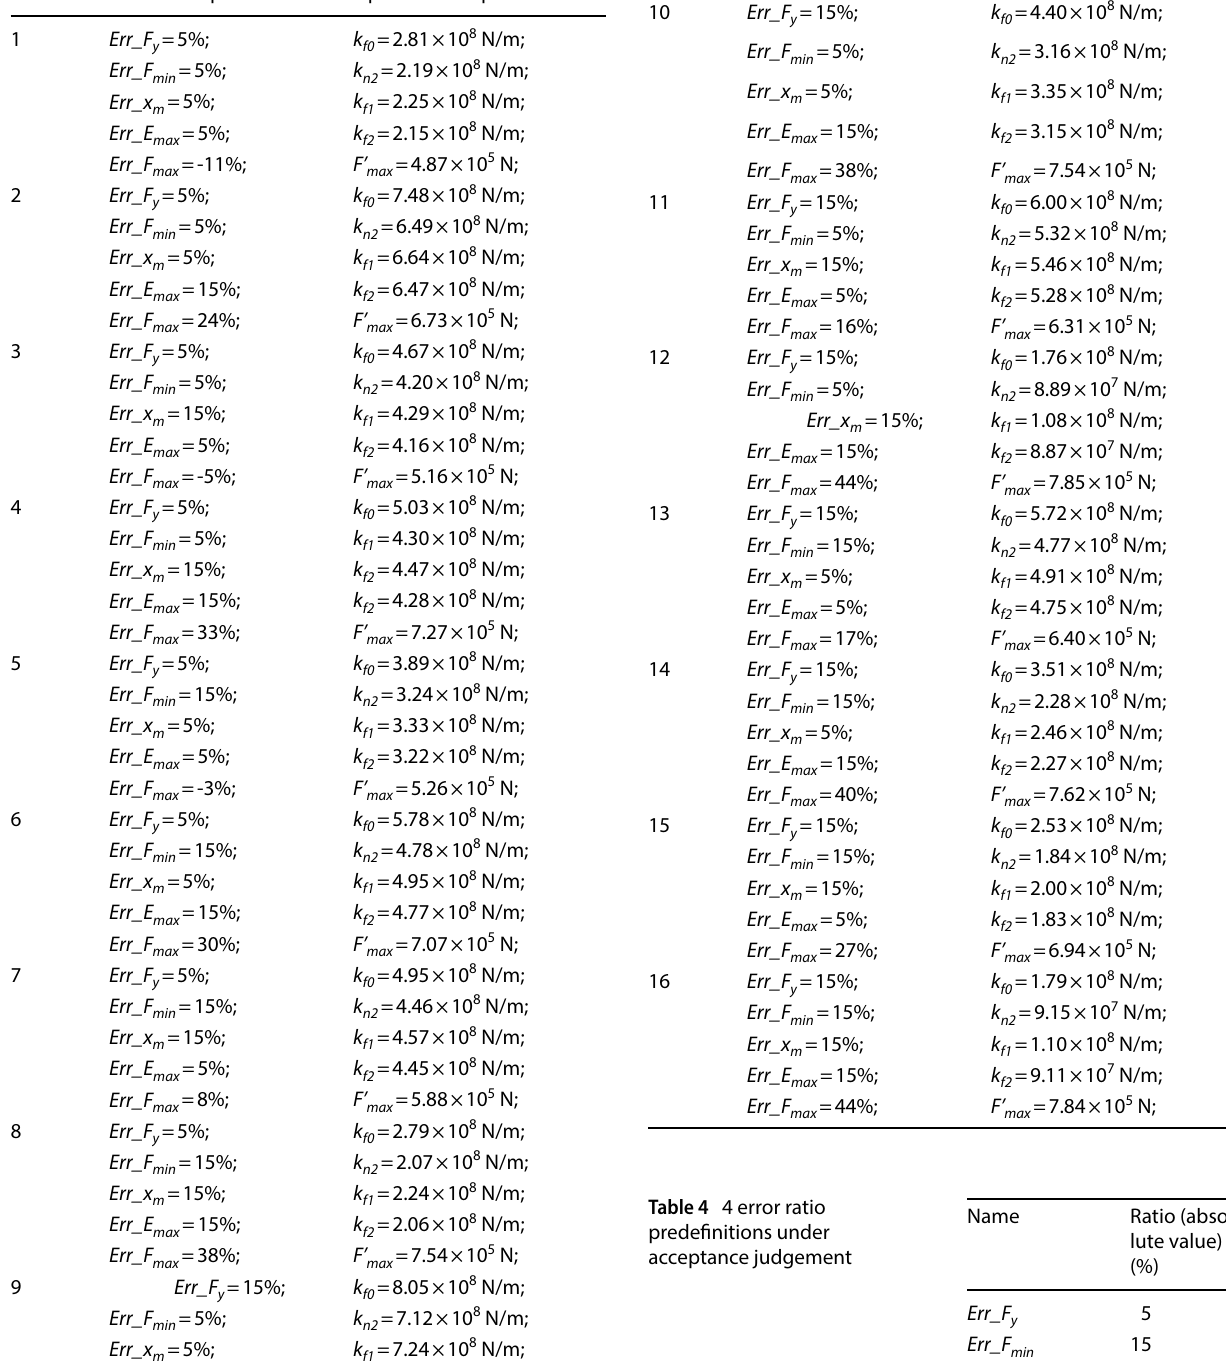
Table 3 Optimization outputs upon configured multiple combina- tions of error ratio predefinitions Trial No.